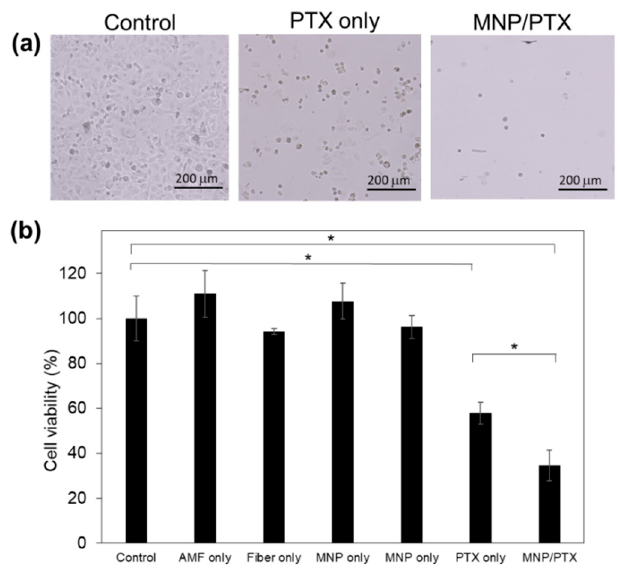
Figure 7. Anticancer effect of PTX on NCI-H23 cells. AMF was applied for 15 min. ( a ) Phase contrast microscopic images of cell treated with the fiber with PTX and MNP/PTX. ( b ) Cell viability after the treatment ( N = 3, * p < 0.05).